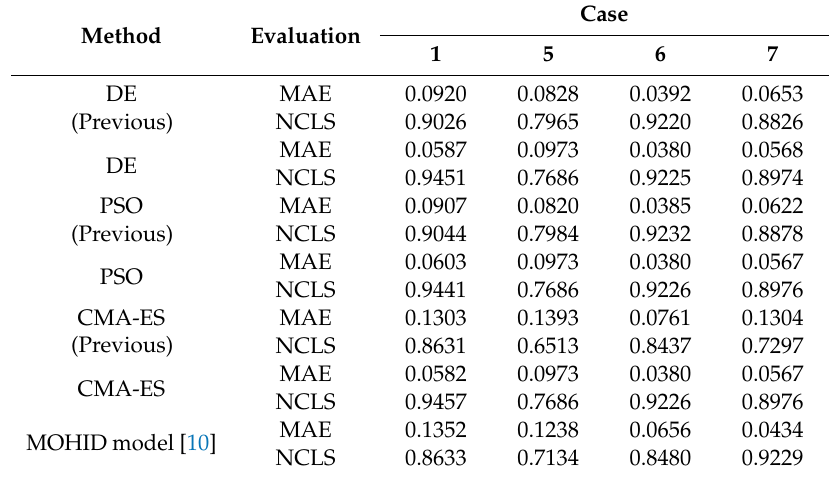
Table 3. Parameters of evolutionary computation